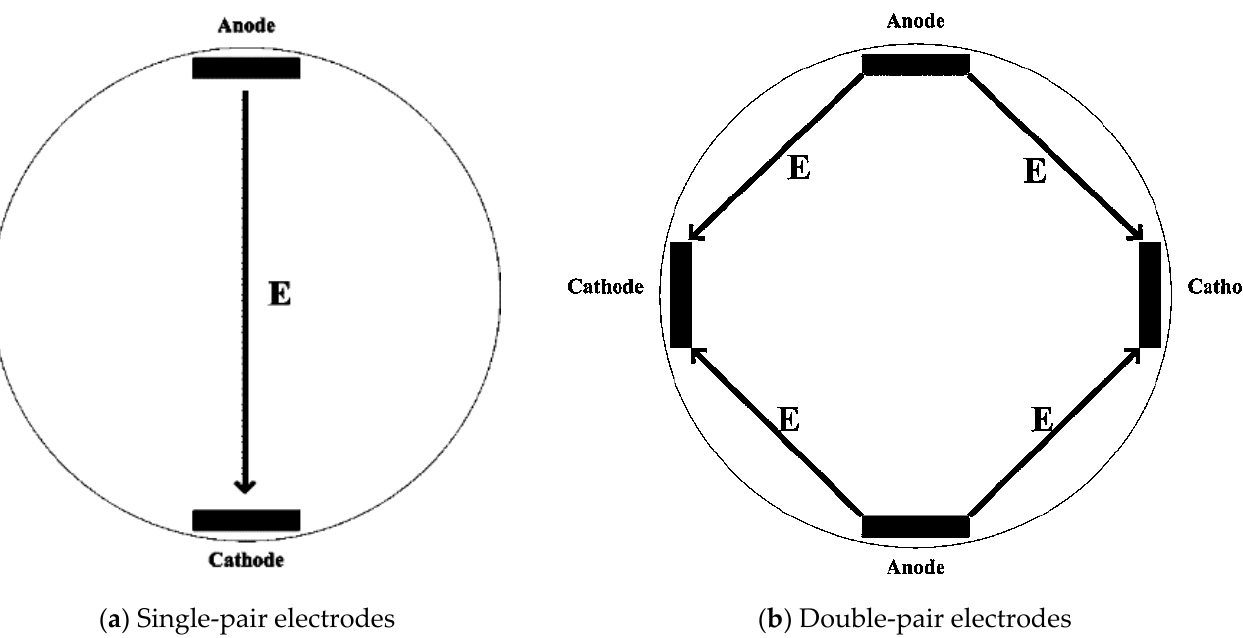
Figure 2. Top-down view of the electrode arrangement for ( a ) single- and ( b ) double-pair electrodes, and the direction of movement of electrical charge within the beaker containing the palm oil mixture.